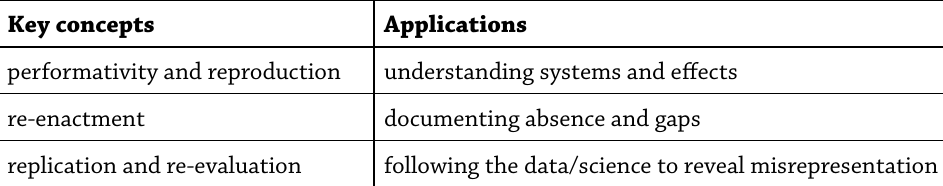
Table 1: Key concepts and applications of re-performance Key